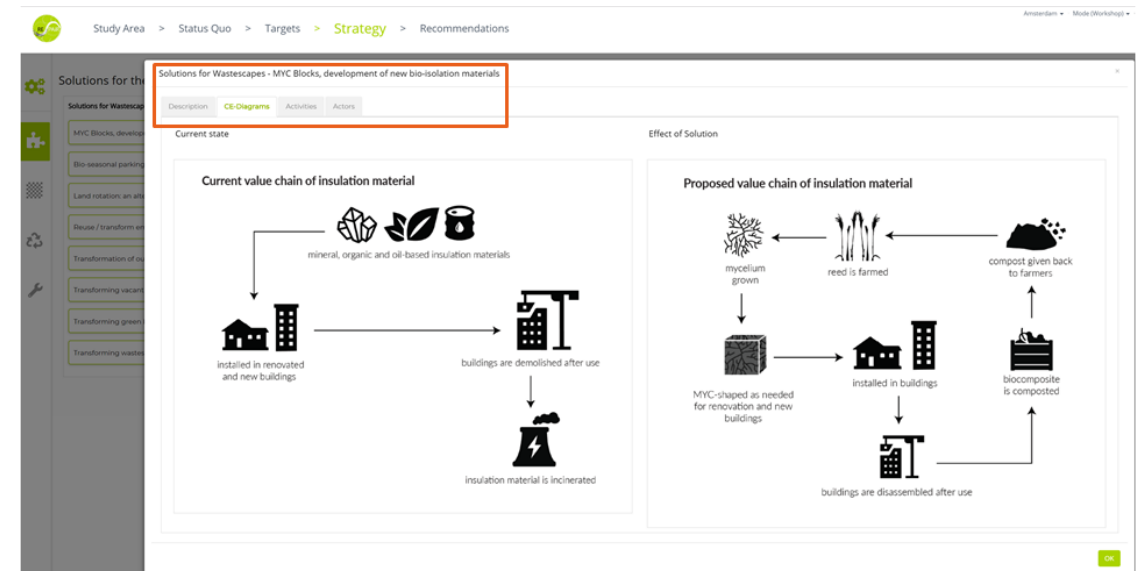
Figure 13. The solution “mycelium blocks” for building bio-isolation materials as modelled in the GDSE.